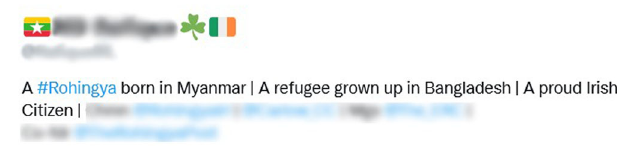
Fig. 4 An Irish Rohingya human rights activist claiming multiple identities. Rohingya diapsora activist claiming multiple identities on